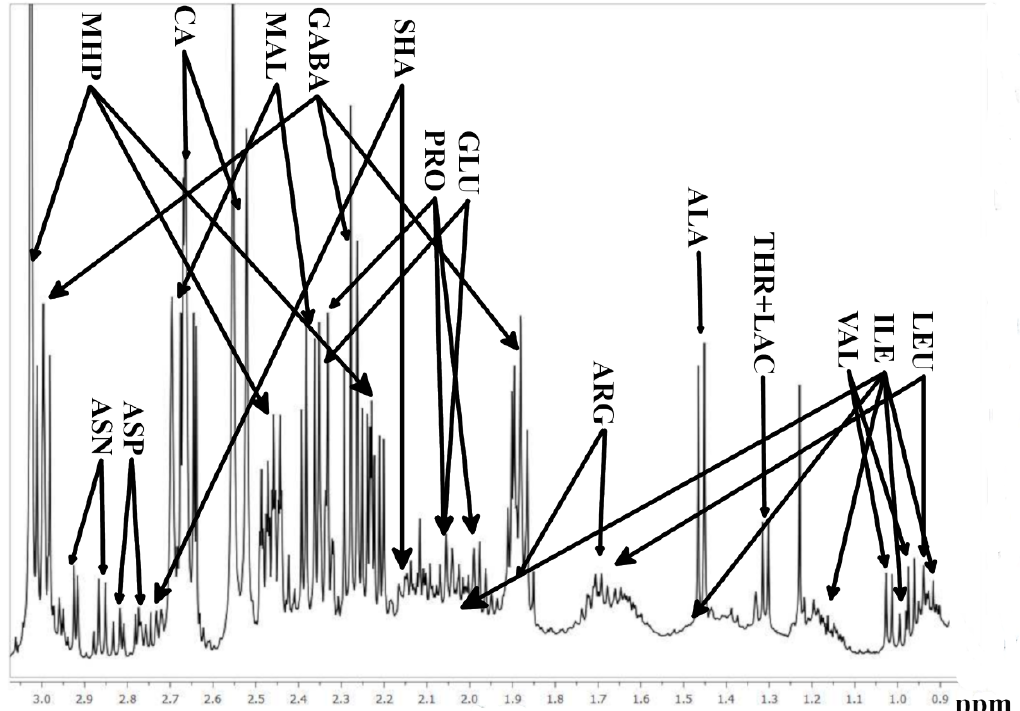
Figure 1. Expansion in the aliphatic region for the 1H-NMR profile at 500 MHz of the water-soluble fraction (PWS) extracted from pistachio powder (sample from Bronte). The main chemical assignment according to the symbol code in Table 1 is driven by arrows; detailed complete assignment is reported in Table S2 (Supplementary Materials).